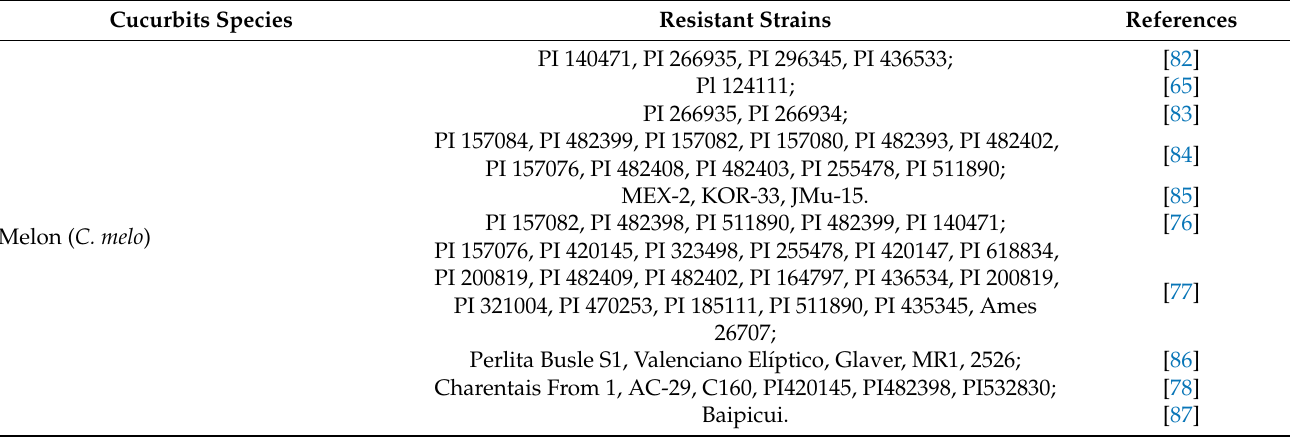
Figure 1. GSB on Cucurbitaceous vegetables and resistance mechanism. Table 3. Resistance resources of Cucurbits to GSB.